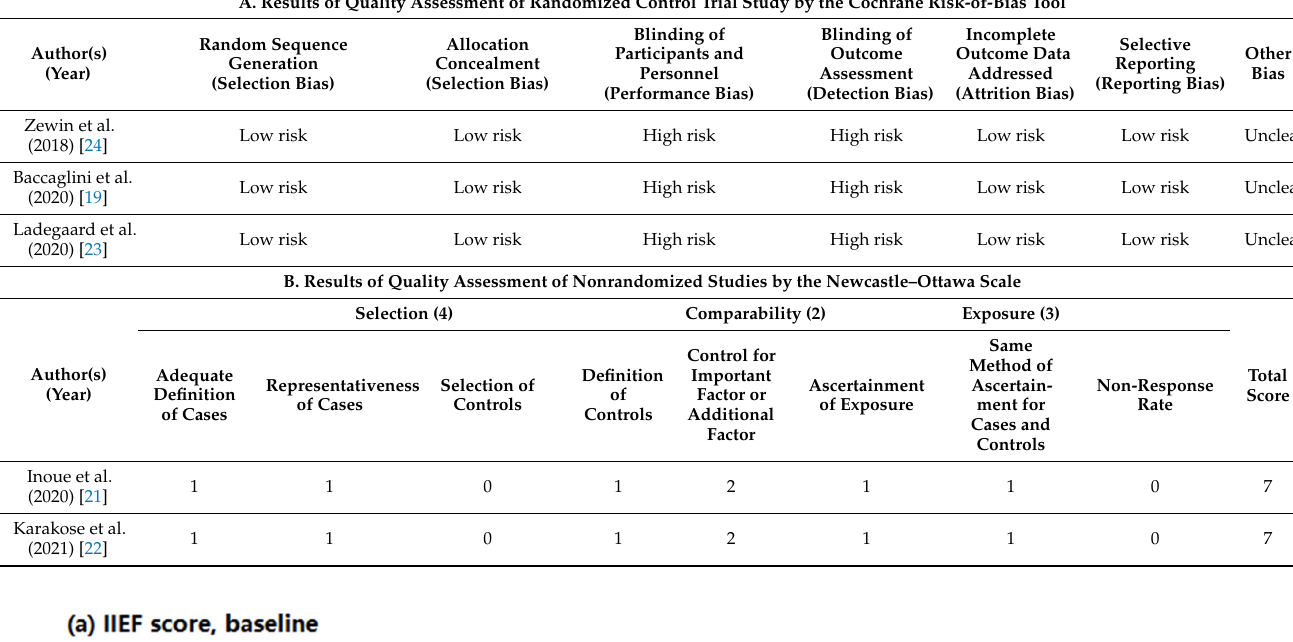
Table 2. The results of quality assessment using the Cochrane risk-of-bias tool and Newcastle–Ottawa scale. A. Results of Quality Assessment of Randomized Control Trial Study by the Cochrane Risk-of-Bias Tool